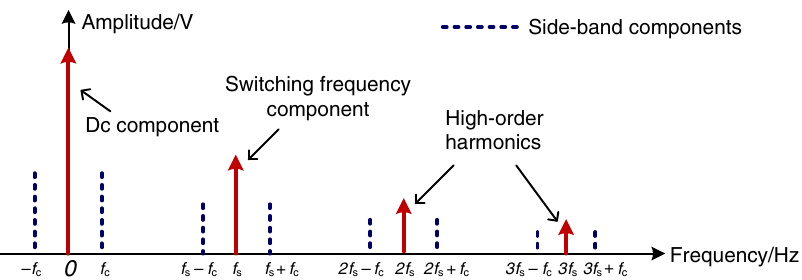
Fig. 3 Output voltage spectrum of a buck/boost converter with PI-compensated output voltage control. The red components are the dc component, the switching frequency component and the high-order harmonics. f s denotes the switching frequency and f c denotes the cut-off frequency of the control loop. The dotted blue lines are the side-band components induced by the PI-compensated voltage control loop. They are distributed on both sides of the red components at frequency intervals equal to the cut-off frequency of the control loop.